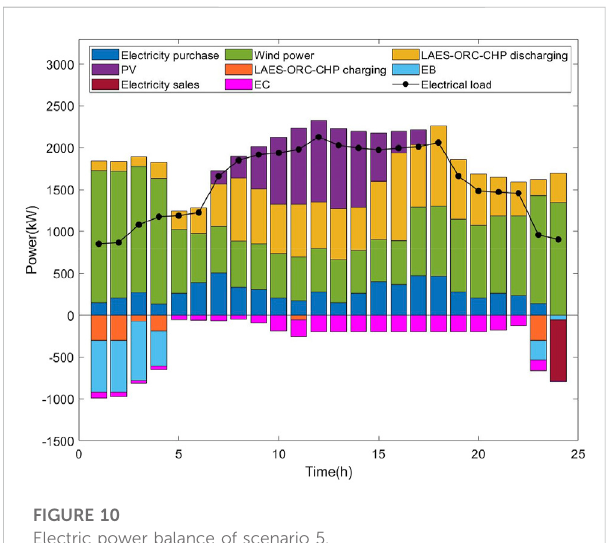
FIGURE 10 Electric power balance of scenario 5.